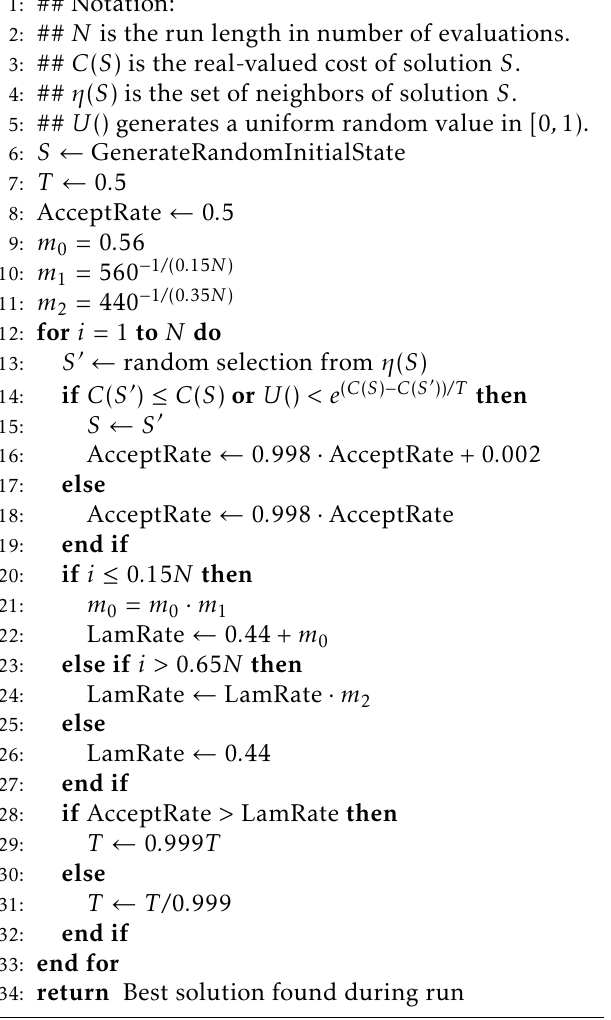
Algorithm 3 Optimized Modified Lam